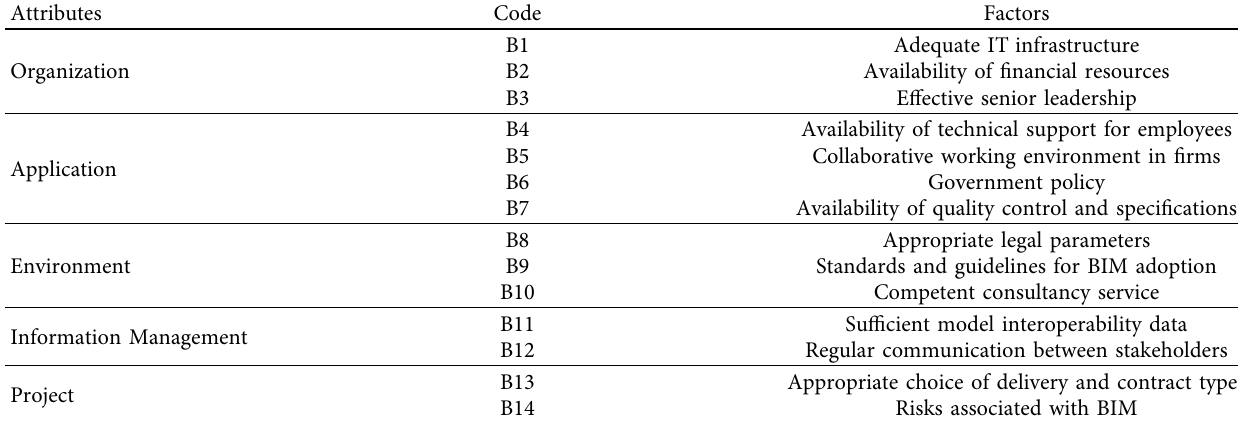
Table 2: BIM implementation drivers adopted from the